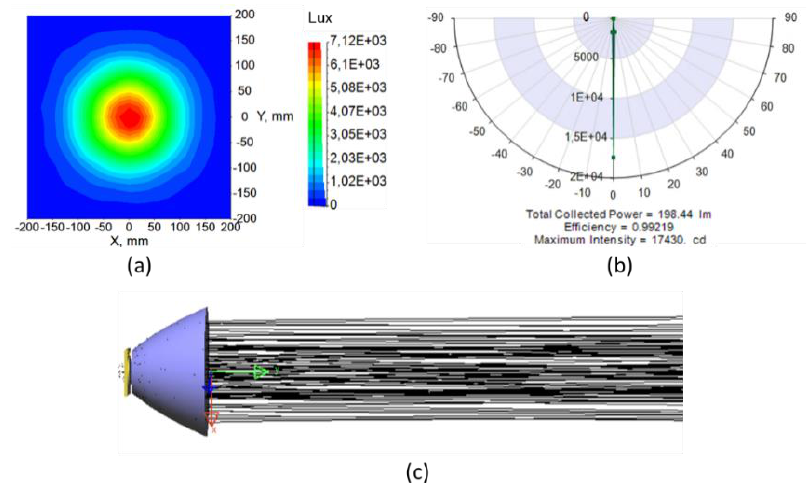
Figure 7. Simulation performance of collimator lens: ( a ) light distribution of output beam; ( b ) viewing angle of LED with collimator at 1.2°; and ( c ) ray tracing of LED with collimator.